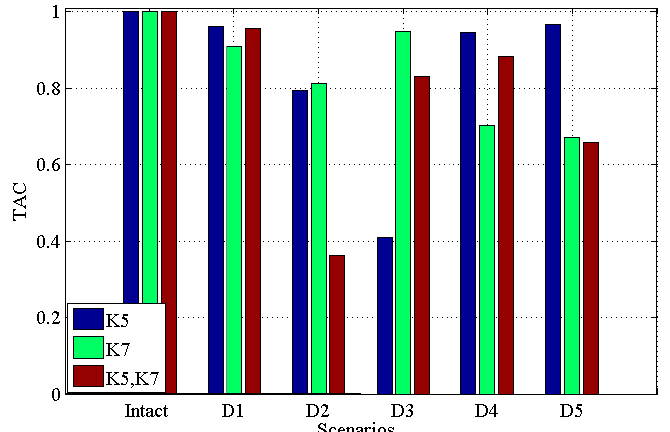
Figure 4. Transmissibility assurance criterion (TAC) for five damaged scenarios with intact scenario for single damage in K5, single damage in K7, multiple damages in K5 and K7, respectively.